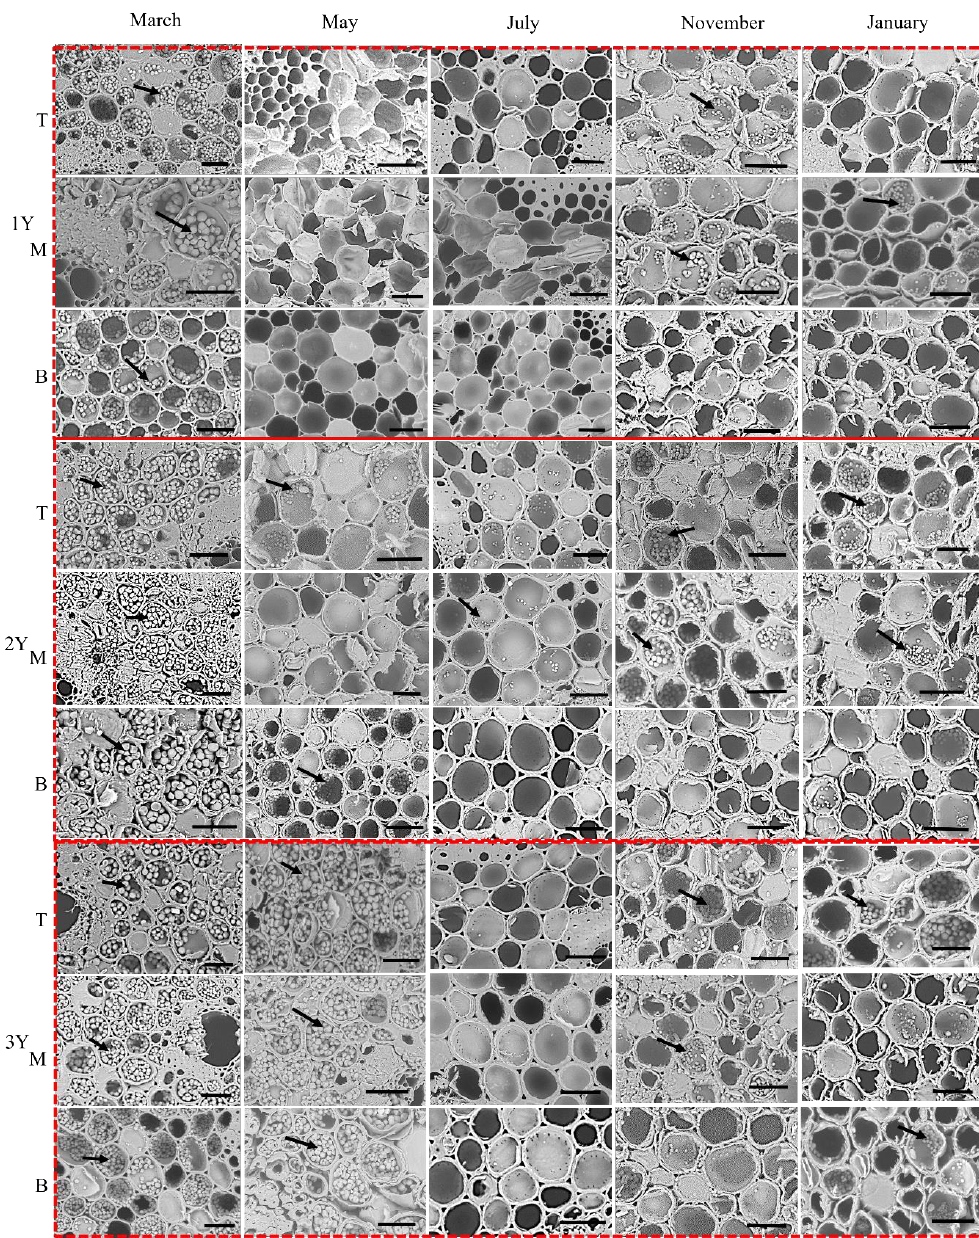
Figure 6. Starch granule distributions in Phyllostachys mannii culms at different phenological stages. 1Y denotes the 1-year culm; 2Y denotes the 2-year culm; 3Y denotes ≥ 3-year culm; T denotes the top portion of the culm. M denotes the middle portion of the culm; B denotes the bottom portion of the culm. Bar = 20 μm (the same hereinafter).